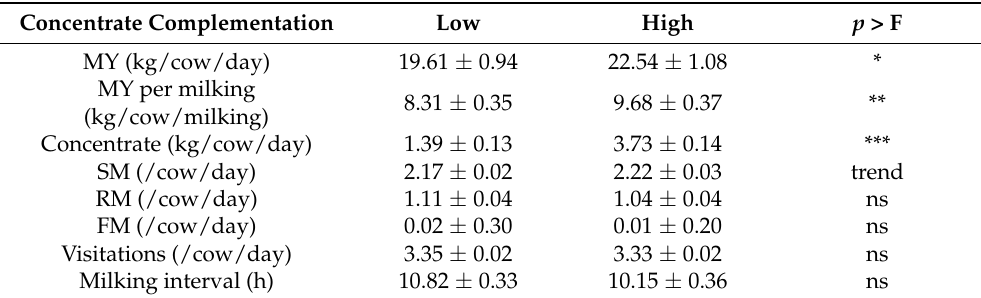
Table 3. Comparison of zootechnical performance of dairy cows fed a low (2 kg/day) or high (4 kg/day) level of concentrate